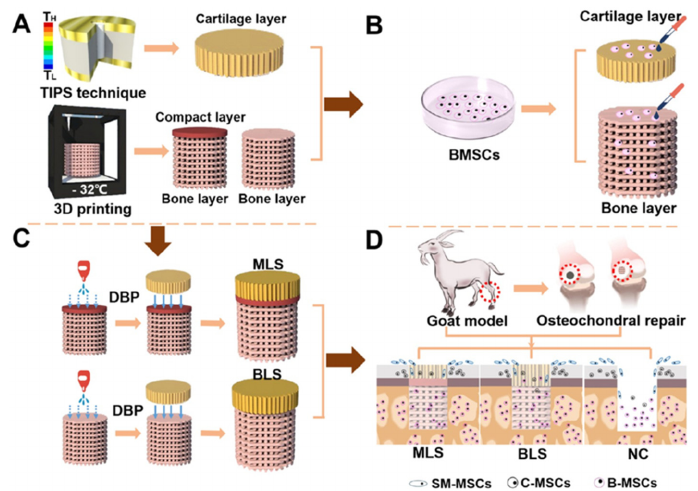
Figure 6. Schematic illustration of the MLS design, Reprinted with permission from ref. [54]. ( A , C ) Preparation process of MLS, ( B ) Adding different functional structures of MSC, ( D ) Implantation of scaffolds in the defect of femo- ral cartilage in goats .